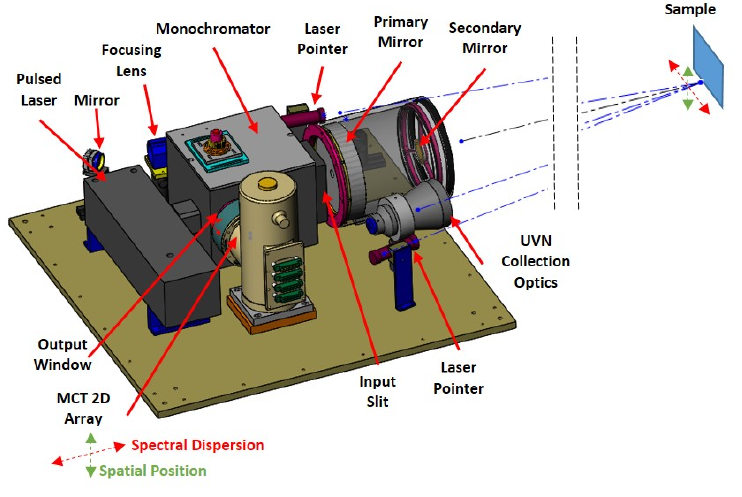
Figure 1. Bench-top simultaneous UV/Vis/NIR (UVN) + LWIR LIBS detection